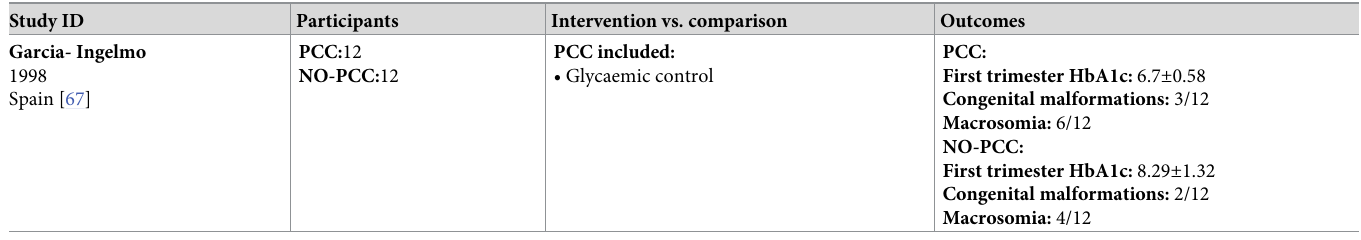
Table 2. Characteristics of included case control